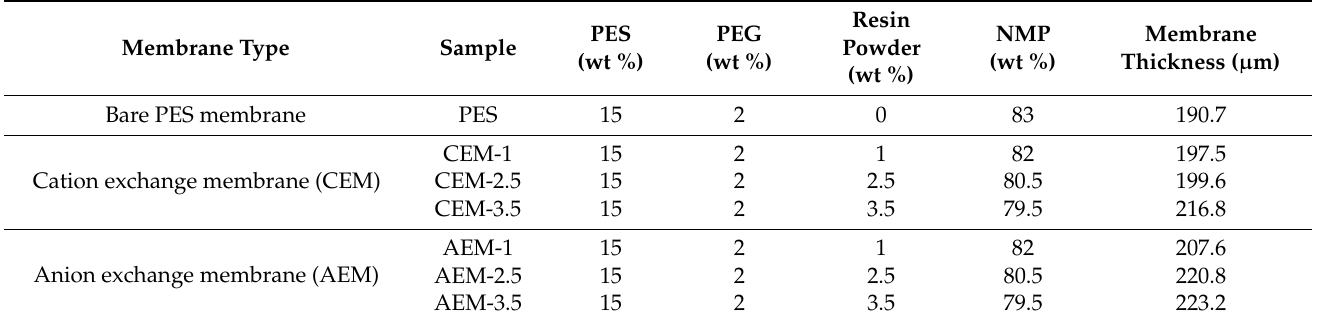
Table 1. Casting mixture composition of the prepared